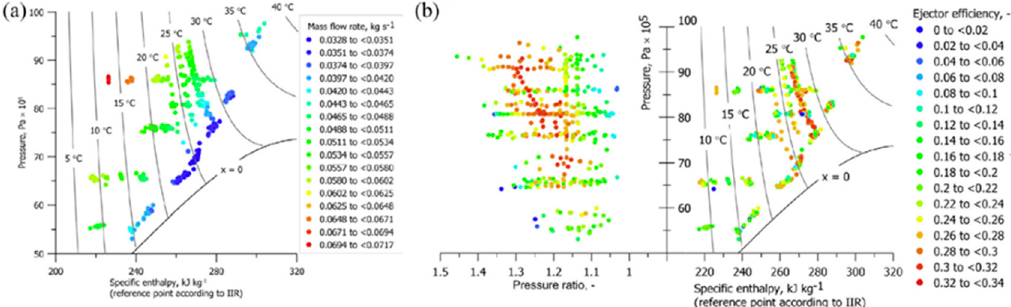
Figure 16. ( a ) Motive nozzle mass flow rate as a function of the motive nozzle inlet conditions for one of the investigated ejectors; ( b ) Ejector efficiency as a function of the motive nozzle inlet conditions and suction pressure ratios for one of the investigated ejectors [15].